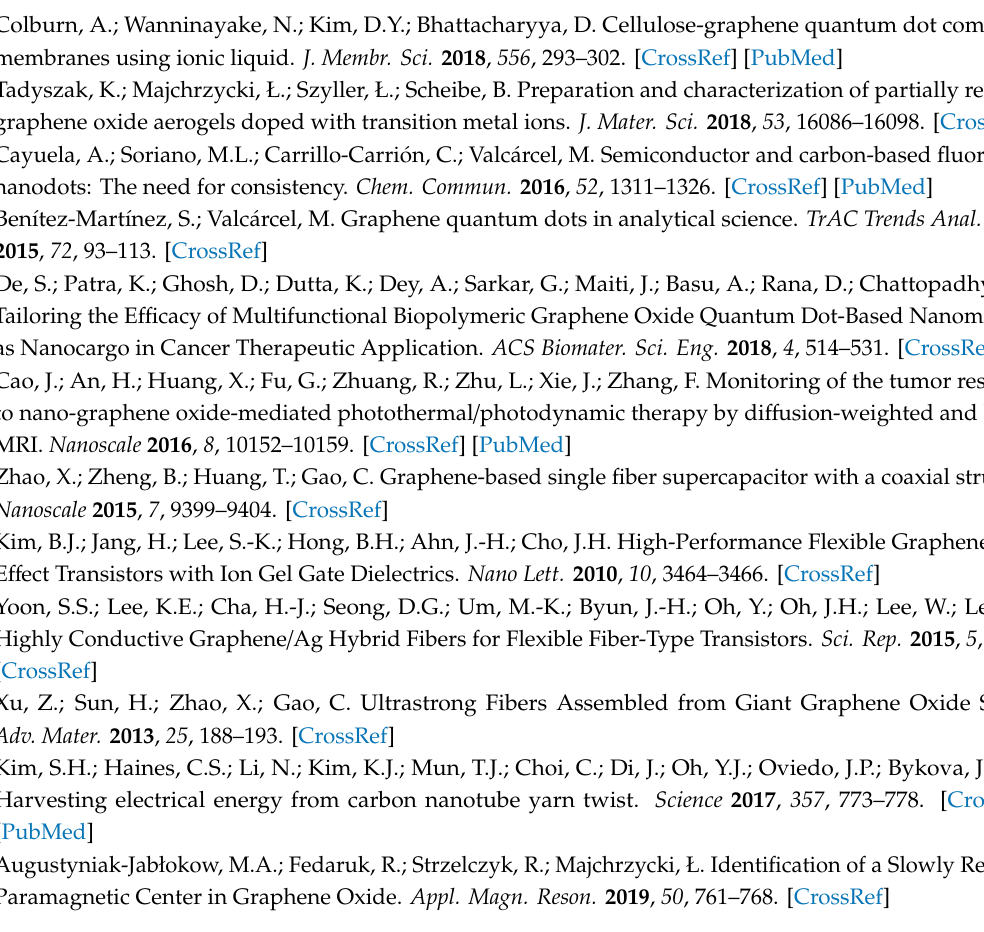
Figure S8: Microscopic image of fiber xerogels, diameter of 40–100 µ m; Videos S1 and S2: Time-lapse record of a drying process in which hydrogel transforms into a collapsed prGO structure called a